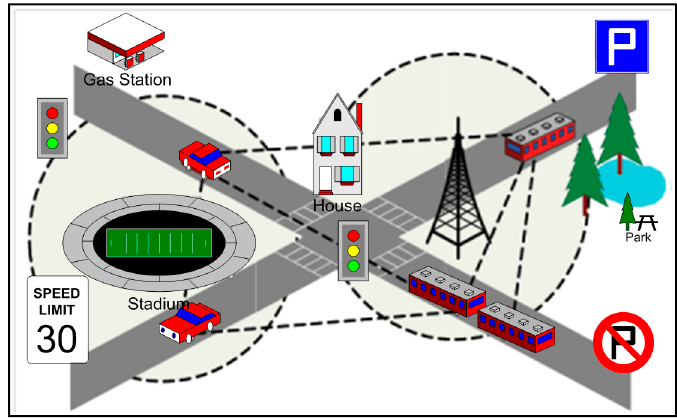
Figure 3. Hybrid architecture.